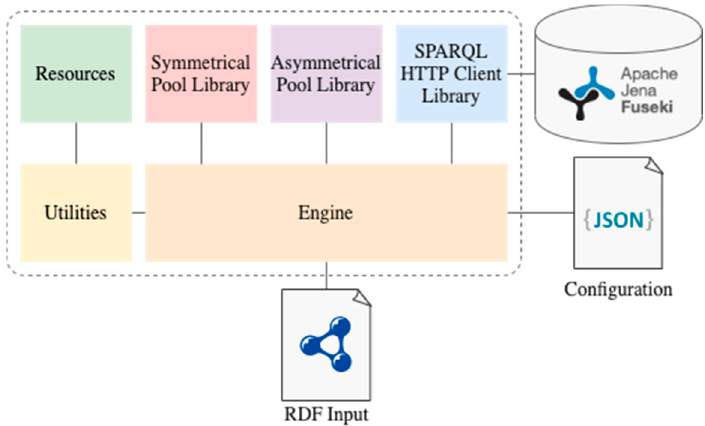
Figure 2. Proposed library’s architecture.